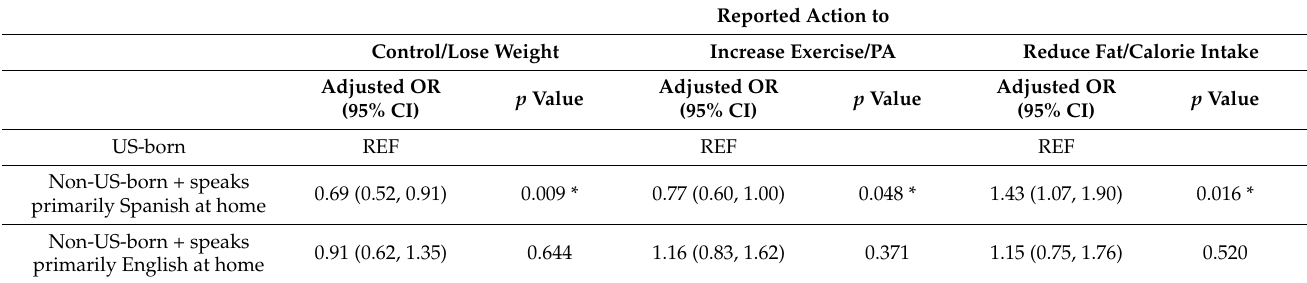
Figure 2. Percent of respondents who reported taking action regarding health care provider counseling. Table 3. Comparative odds ratios for taking action on health care provider counseling according to acculturation level.